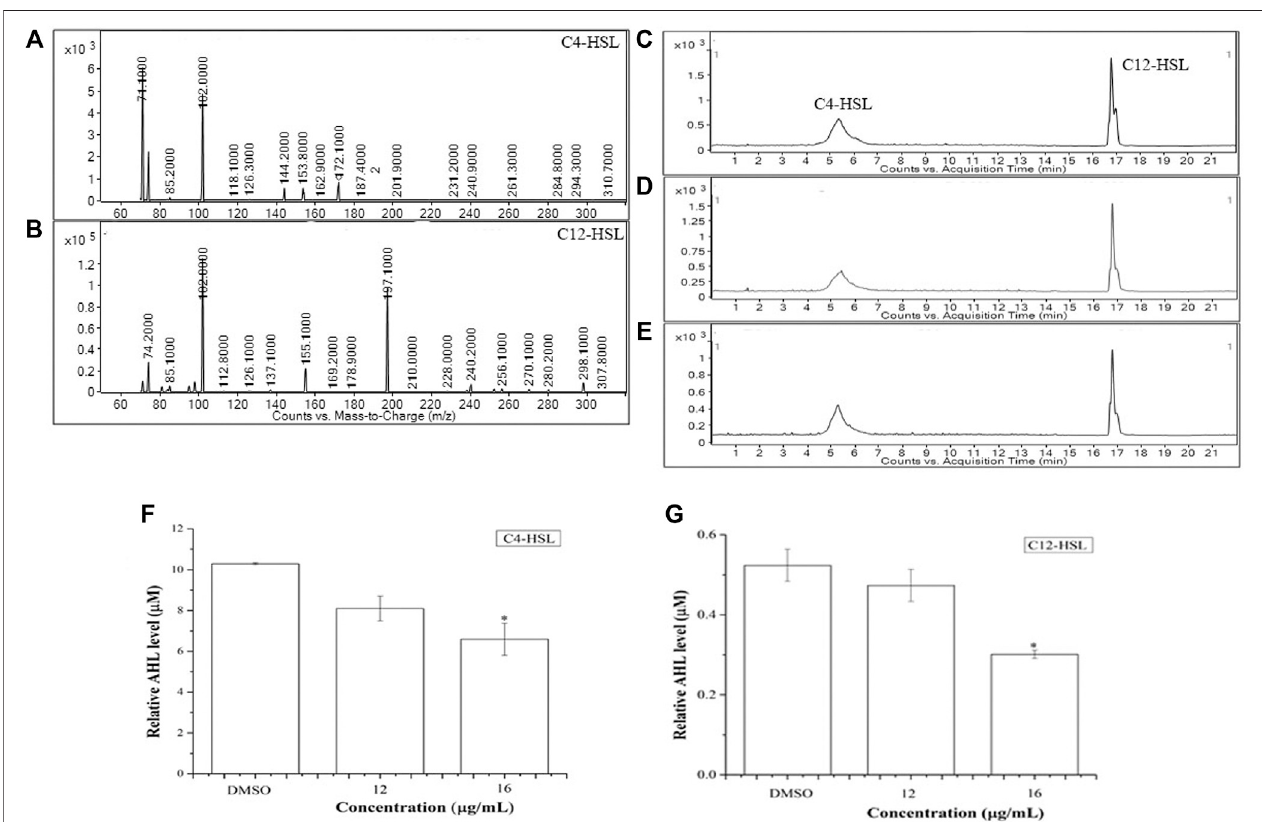
FIGURE 3 | Relative quanti fi cation of AHL molecules (C4-HSL and 3-oxo-C12-HSL) in response to BG138, using UPLC-ESI-MS/MS. Product ion spectra of C4- HSL and 3-oxo- C12-HSL (A,B) . Chromatograms of C4-HSL and 3-oxo-C12-HSL produced by P. aeruginosa treated with DMSO (C) and BG138 (12, and 16 μ g/ml) (D,E) . Quantitative analysis of C4-HSL and 3-oxo-C12-HSL treated with 12 and 16 μ g/ml of BG138 (F,G) . Error bars are the standard error of three measurements. Statistical differences were determined by ANOVA followed by Tukey test. p < 0.05 (*) p < 0.01 (***) versus DMSO control.